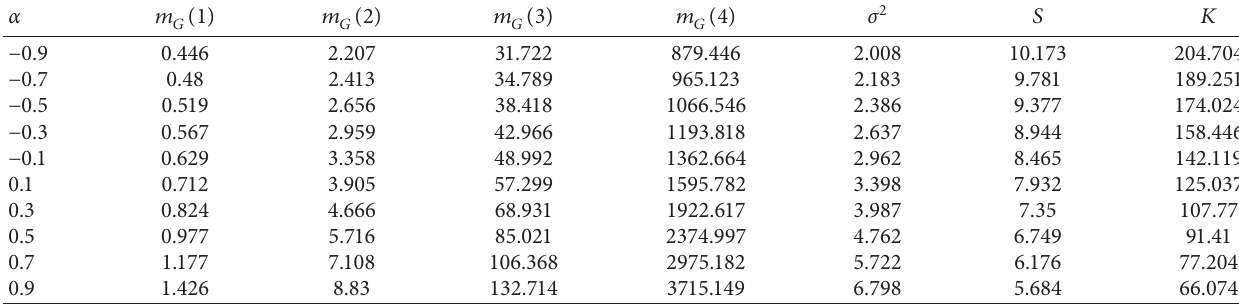
Table 2: Values of moment measures of the NTMW distribution for c � 0 . 5 and k � 0 . 5 and different values for α . α m G ( 1 )